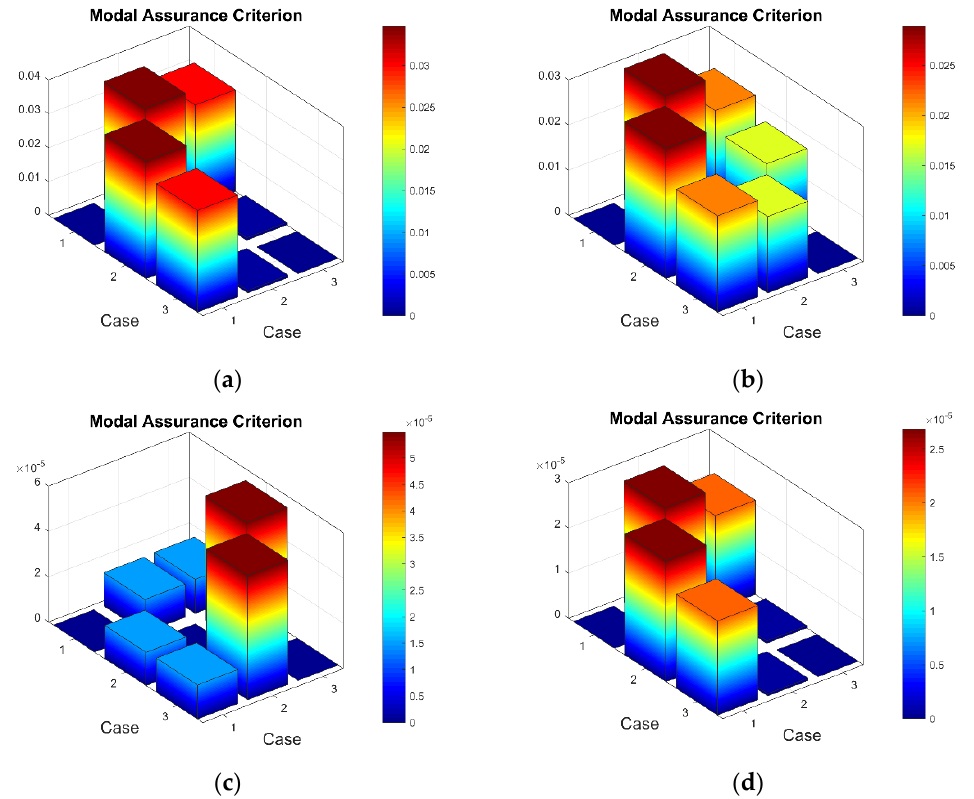
Figure 14. The selected MAC values for strain data obtained using 1, 2 and 3 V vibration amplitudes: ( a ) healthy plate for the first resonant frequency, ( b ) damaged plate for the first resonant frequency, ( c ) healthy plate for the seventh resonant frequency, ( d ) damaged plate for the seventh resonant frequency.